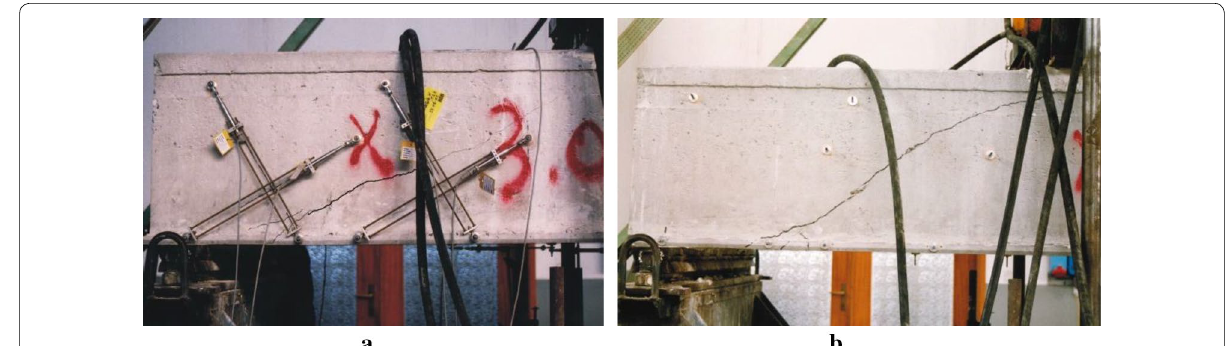
Fig. 8 Shear tests: experimental crack pattern in correspondence of the ultimate applied load for a slab H50-s1 and b slab H50-s2.